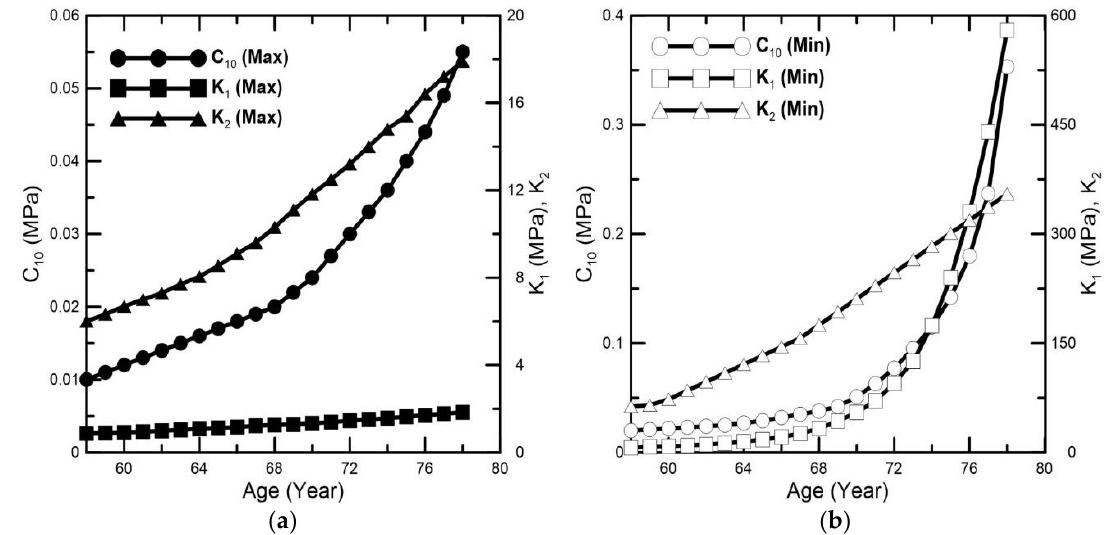
Figure 8. Variation of the material parameters according to age in the trend line range (( a ) maximum and ( b ) minimum).